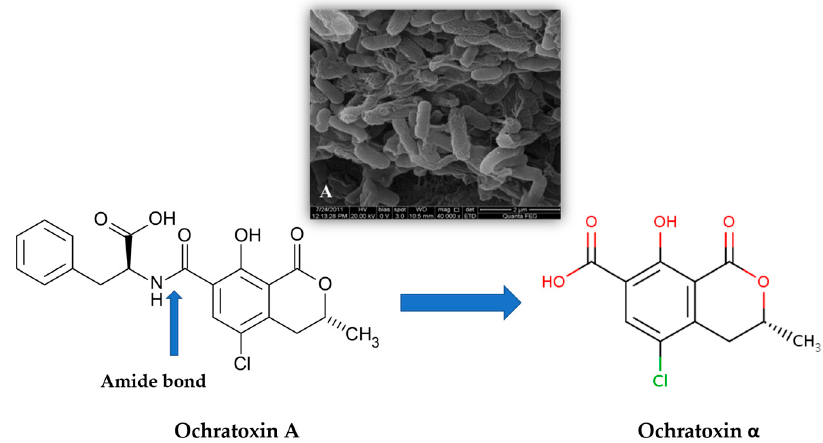
Figure 1. Proposed cleavage of ochratoxin A by Cupriavidus basilensis Ő R16. The amide bond hydrolysis forming ochratoxin α as the major degradation product [19]. A— Scanning electron microscope (SEM) micrograph, magnification of 40,000 of a Cupriavidus basilensis biofilm [30].